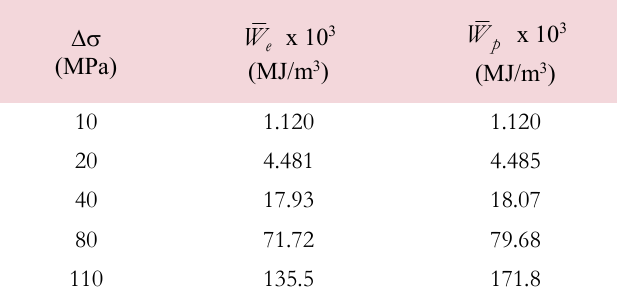
Table 3: Mean values of SED as determined from linear elastic and elasto-plastic analyses (control volume R 0 =0.28 mm).